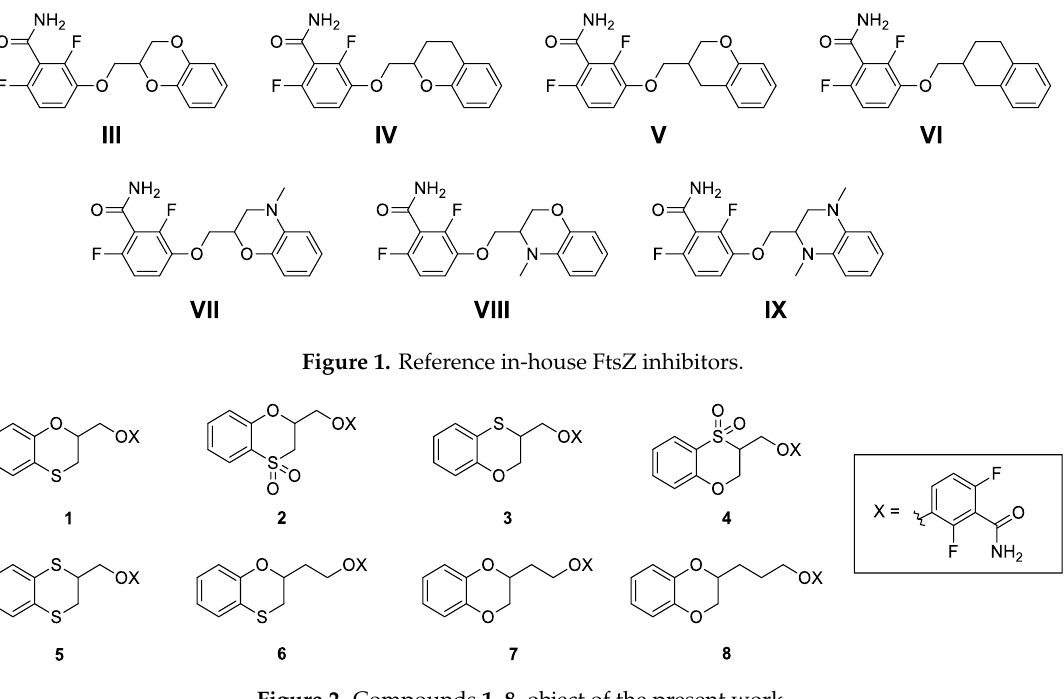
Figure 2. Compounds 1–8 , object of the present work.